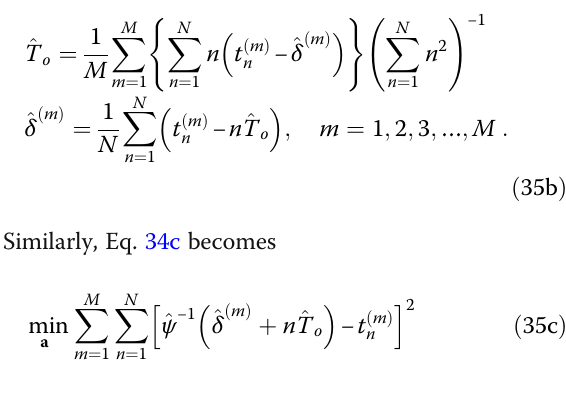
The performance can be expected to improve as the inequality NM / K >> 1 is strengthened. An example of M ¼ 3 is the well-known QRS complex in an EKG signal, which is repeated with every heartbeat. As in the case of the implicit solution Eq. 34b, Eq. 35b is